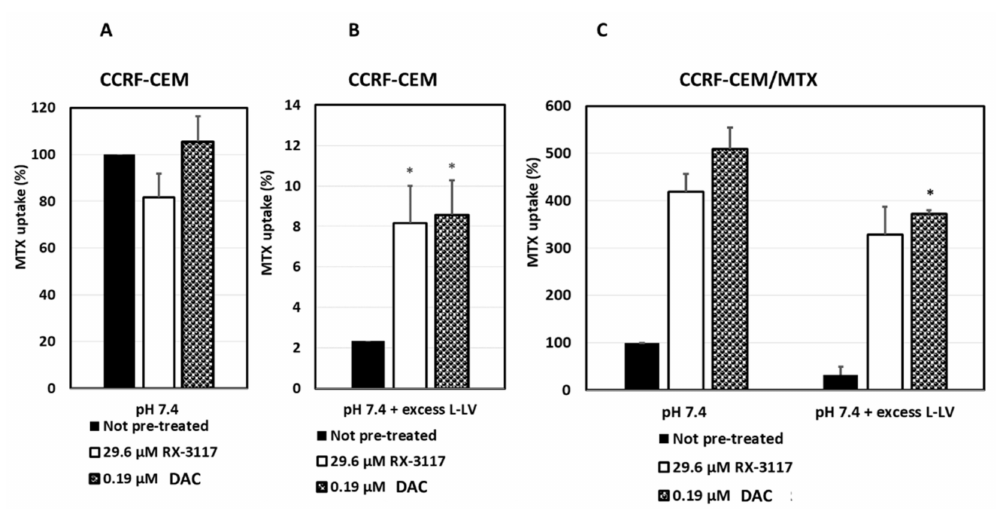
Figure 3. MTX uptake in CEM and CEM / MTX cell lines. Three conditions were used for CEM and CEM / MTX cells: control and 24 h pre-treatment with 26.9 µ M RX-3117 or 0.19 µ M DAC. Values are means ± SEM of three separate experiments. A : uptake of MTX in CEM cells with the uptake in untreated cells for each experiment normalized at 100%. B : uptake of MTX in CEM cells when RFC was completely blocked due to the addition of excess 1 µ M L-LV. C : the left 3 bars show uptake of MTX in CEM / MTX cells, with the uptake in untreated cells for each experiment normalized to 100%. The right 3 bars show the uptake of MTX in CEM / MTX cells when residual RFC is blocked due to excess L-LV. *, significantly di ff erent from control untreated cells at the level of p <